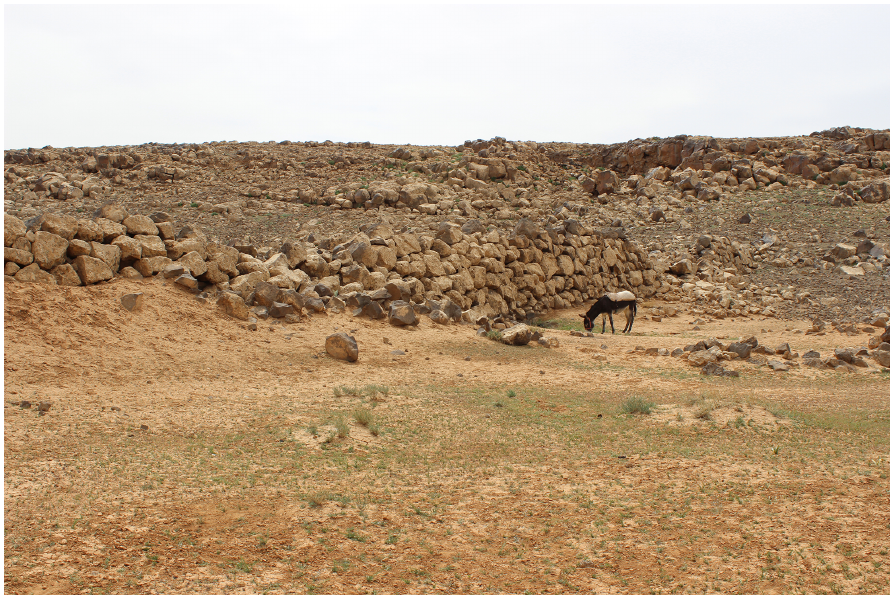
Figure 3. The Jawa dam, with the interior of the dam facing the viewer. Note the donkey for scale. c (cid:13) Bernd Müller-Neuhof (DAI-Orientabteilung), used by